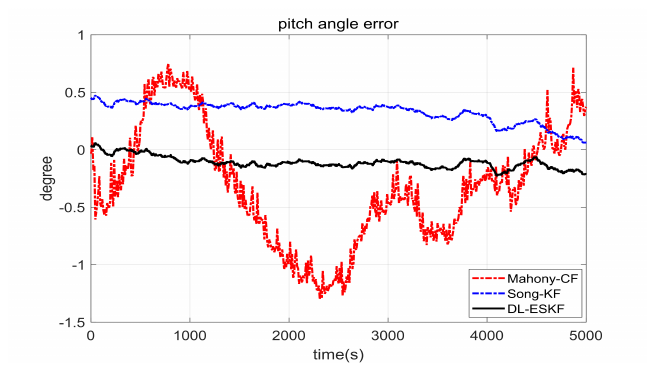
Figure 5. Roll angle error under static conditions.